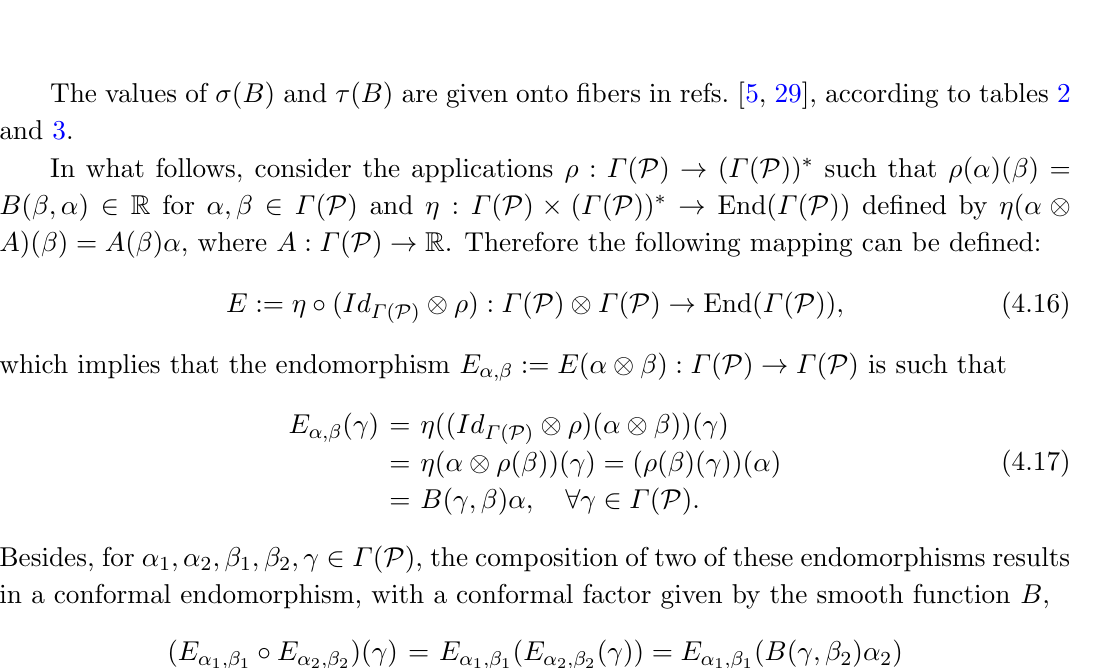
Table 2 . Symmetry values of B . Table 3 . Type values of B